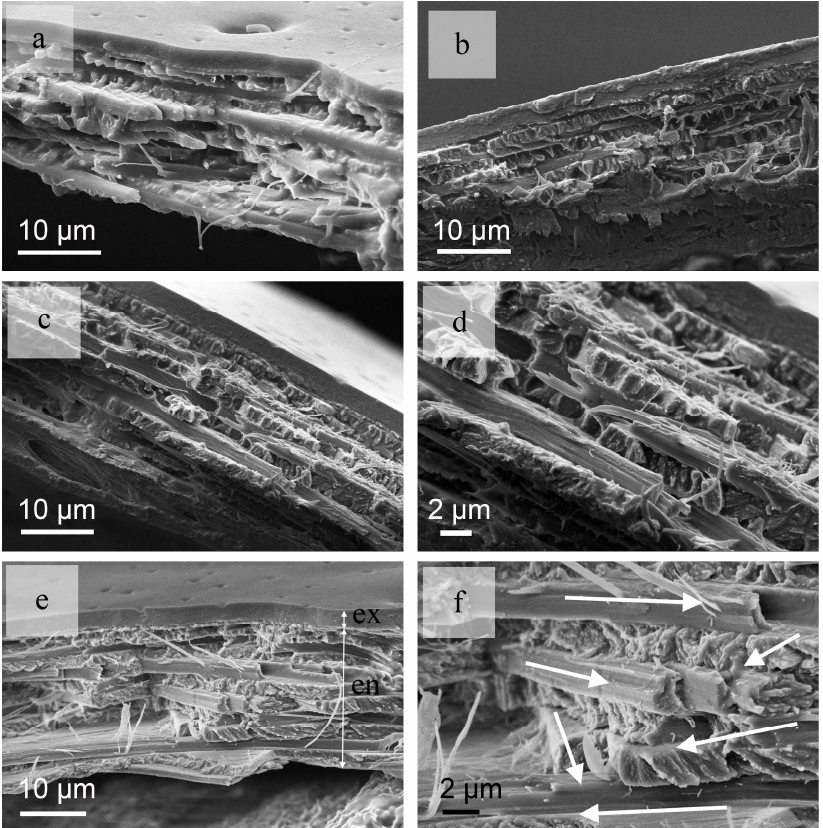
Figure 2. The cross-section view SEM (scanning electron microscopy) images of fiber layers from the C. septempunctata L. elytra. ( a – c ) show the full fiber layers; ( d ) shows higher magnification sections of fiber layers; ( e ) shows the thickness of the exocuticle (ex) and the endocuticle (en) in the C. septempunctata L. elytra; ( f ) shows higher magnification sections of endocuticle.